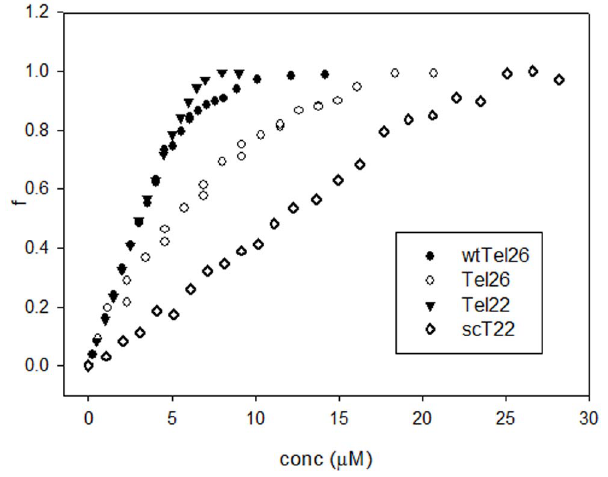
Figure 5. Ligand saturation is modulated by DNA folding. Fraction of rearranged G-quadruplex (f) induced by increasing concentrations of (K34) 2 Ni(II) at 25 u C in 10 mM Tris, 20 mM KCl, pH 7.5. Oligonucleotides concentration: 4 m M.